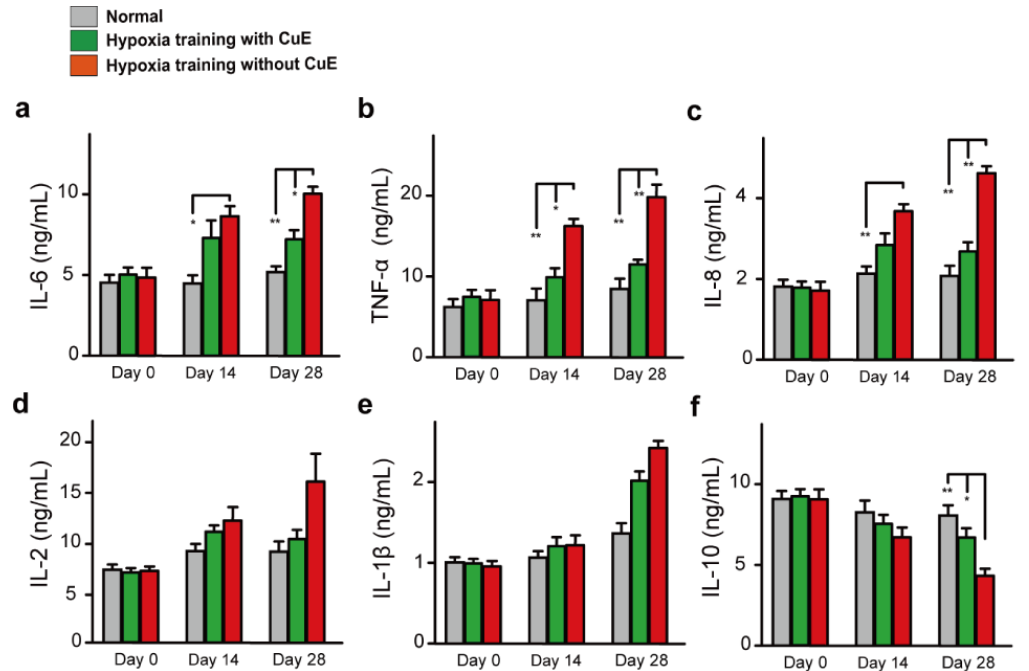
Figure 2. Changes in serum pro-inflammatory factors. (a) IL-6; (b) TNF-α; (c) IL-8; (d) IL-2; (e) IL-1β; (f) IL-10. Results are presented as means ± SEM (n=6 each group). * P < 0.05, ** P <